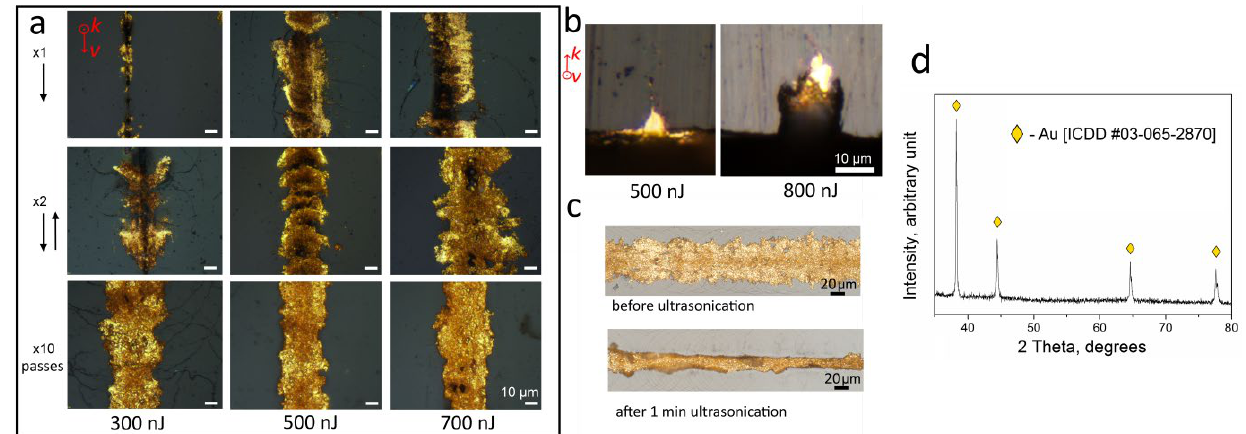
Figure 2. ( a ) Reflected light microscope images of the laser-deposited gold traces at different pulse energies and numbers of laser beam passes; ( b ) Reflected light microscope images of the cross-section of gold traces fabricated by 100 laser beam passes; ( c ) laser-deposited gold traces before and after ultrasound treatment ( d ) X-ray diffraction pattern of the laser-written Au square. Vectors v and k indicate laser writing direction and laser beam propagation direction, respectively.